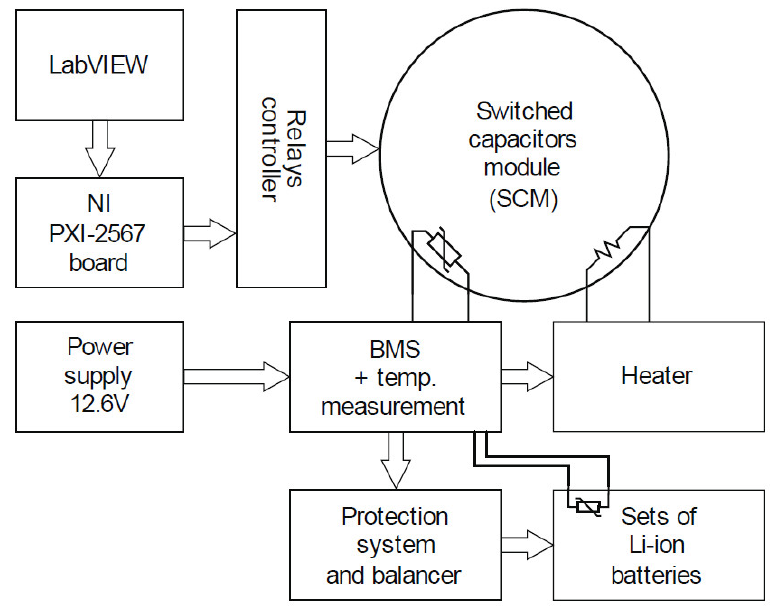
Figure 2. Block diagram of the switched capacitor device.